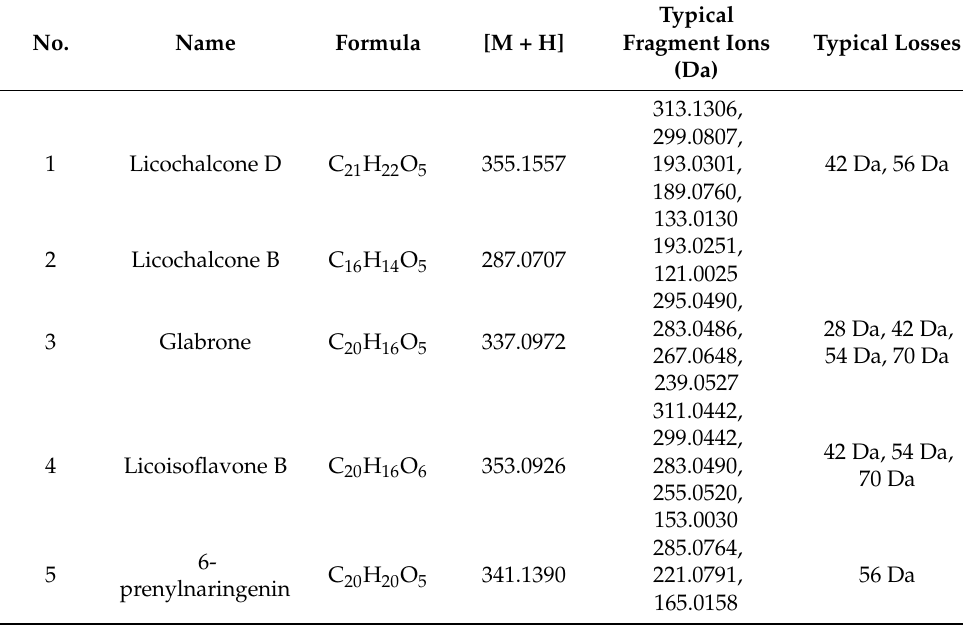
Table 1. The MS data of the reference compounds.